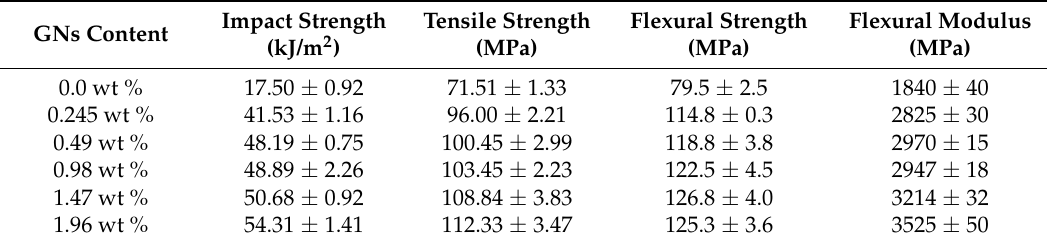
Table 2. The mechanical properties of neat epoxy and epoxy/GPLP composites.